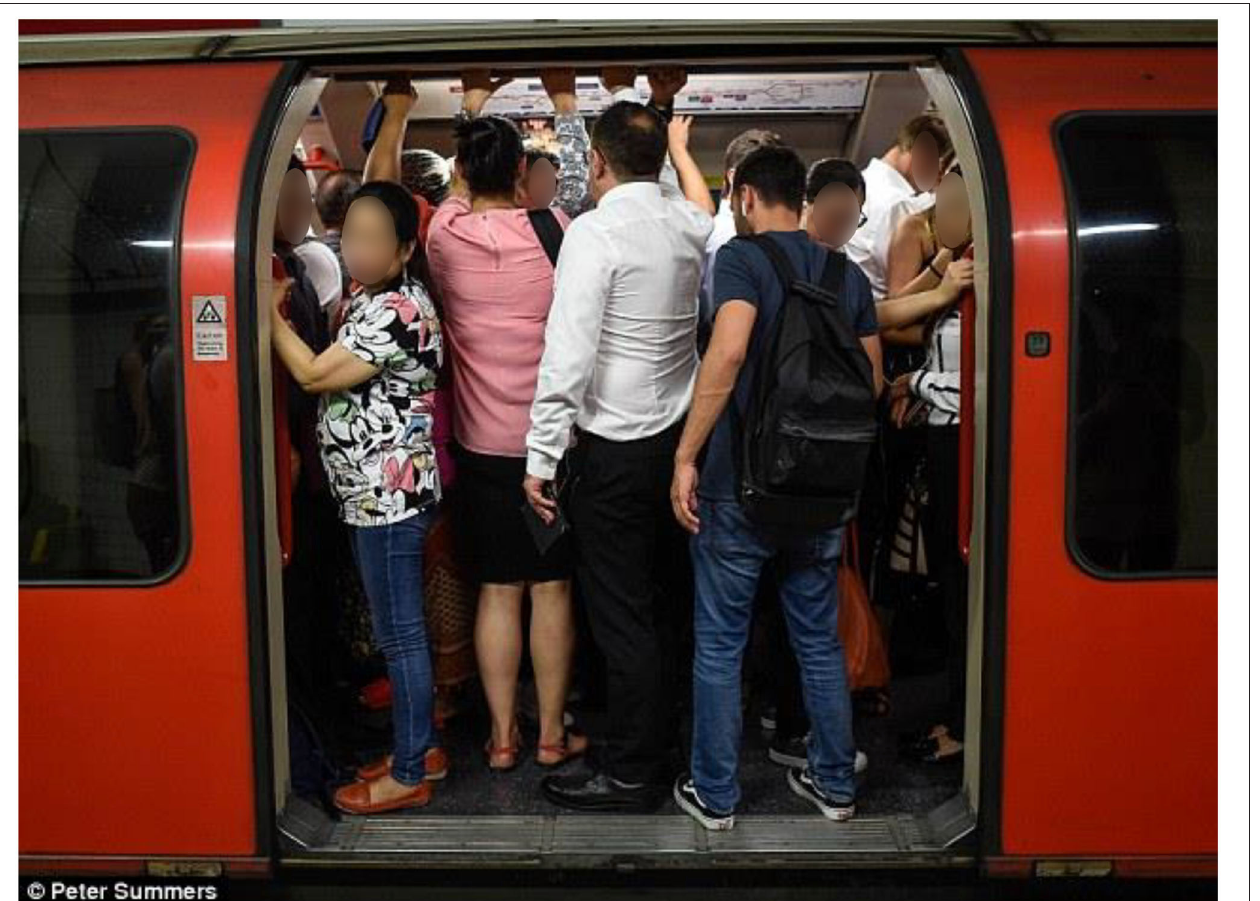
FIGURE 1 | Do we ever get closer to unknown strangers than on the underground? [Copyright P.